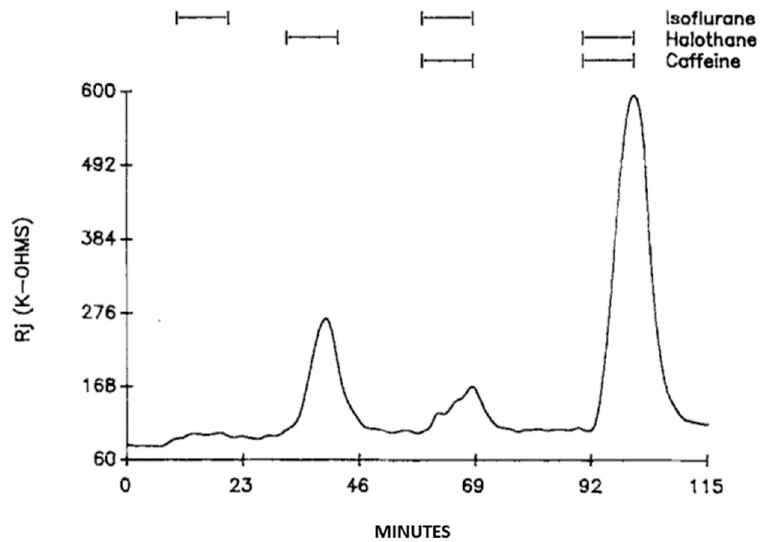
Figure 10. Time course of Rj in crayfish axons treated with either isoflurane or halothane in the presence or absence of 20 mM caffeine. As for heptanol and halothane, caffeine has a pronounced effect on the uncoupling efficiency of isoflurane. However, isoflurane has a significantly weaker effect on Rj than halothane. Adapted from [16] .